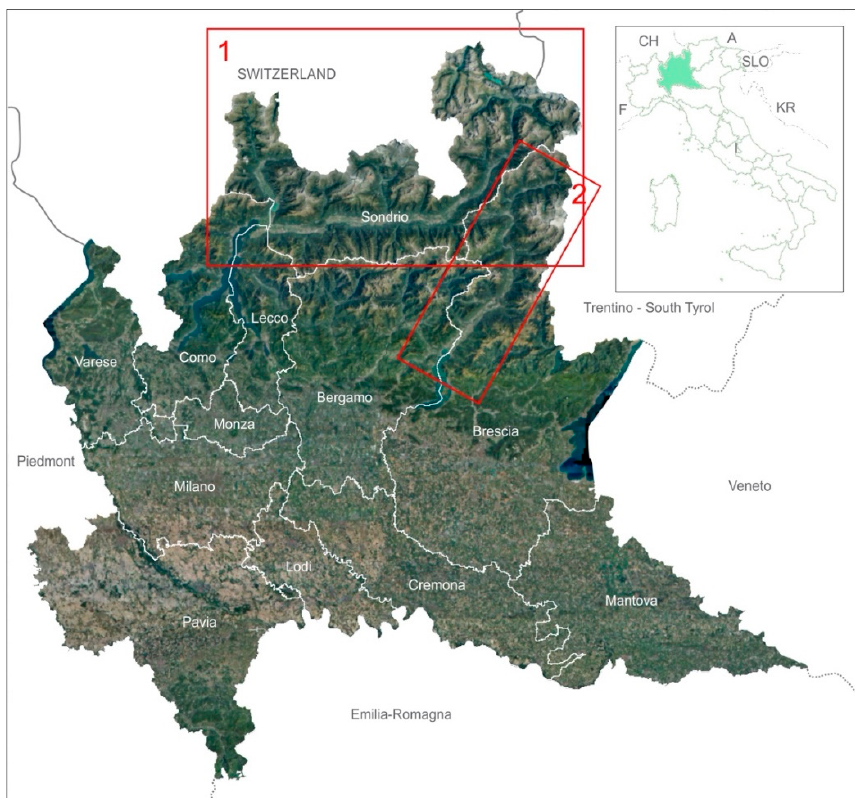
Figure 1. Location of the study areas in the alpine sector of the Lombardy Region: ( 1 ) Sondrio Province (Valtellina); ( 2 ) Brescia Province (Valcamonica).